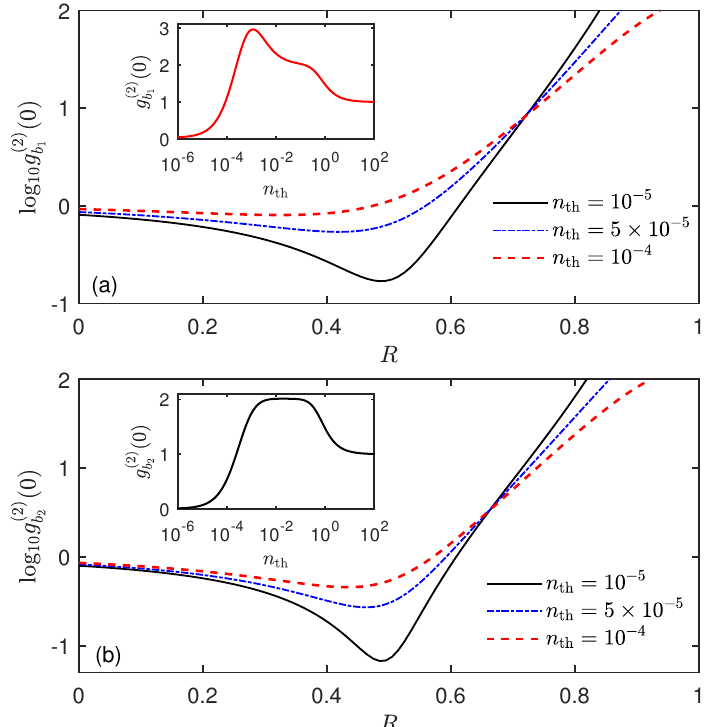
( 2 ) ( 0 ) of the SAW modes ( a ) b 1 b i ( 2 ) ( 0 ) and g ( 2 ) ( 0 ) b 1 b 2